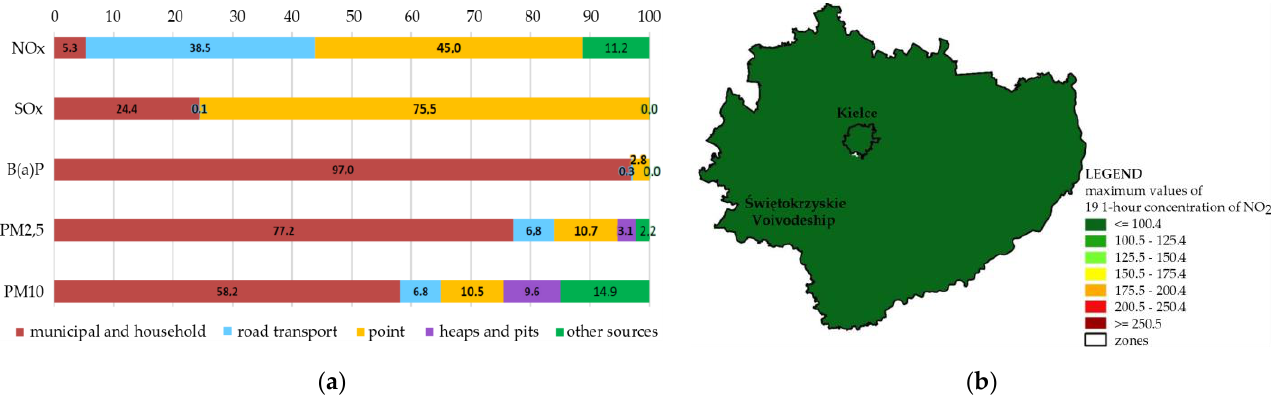
Figure 5. ( a ) Percentages of the emission sources of specific air pollutants in Świętokrzyskie Voivodeship; ( b ) Spatial distribution of maximum values of 19 1-h concentration of NO 2 in Świętokrzyskie Voivodeship and in Kielce city in 2020.